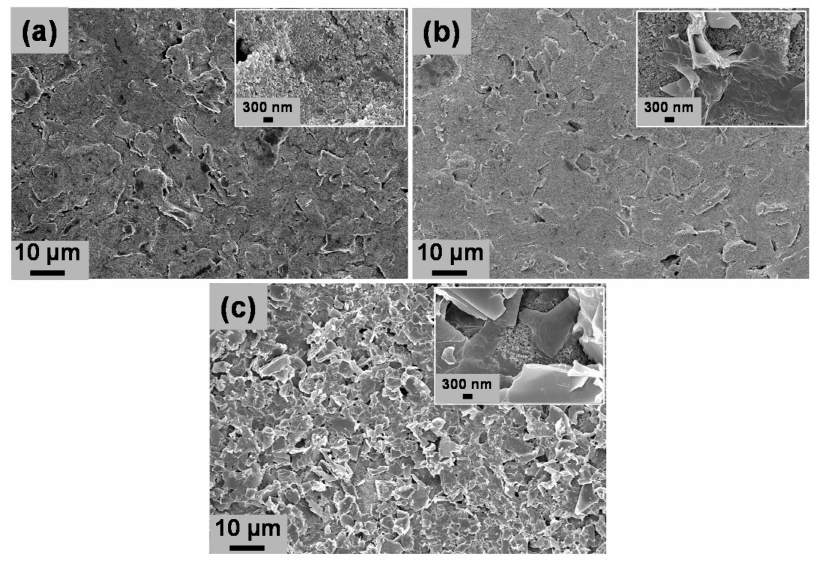
Figure 1. FE-SEM images of ( a ) bare SPCE; ( b ) rGO/SPCE; ( c ) PD b S–rGO/SPCE. Insets are the highly magnified